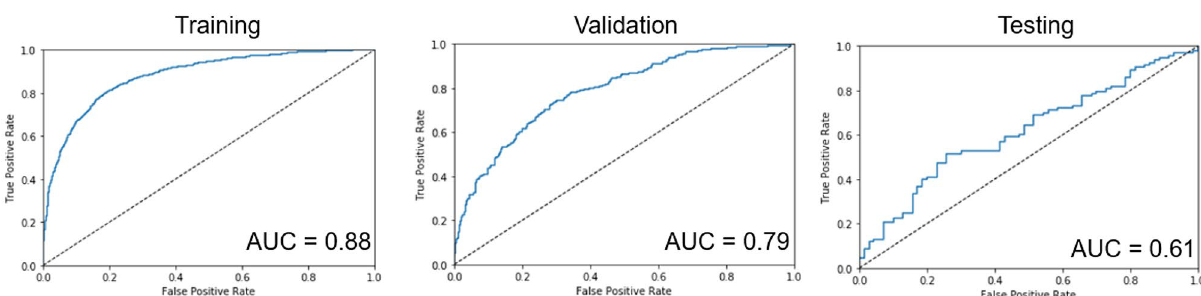
Figure 5. The dNN’s training, validation, and testing ROC curves with associated AUC values.